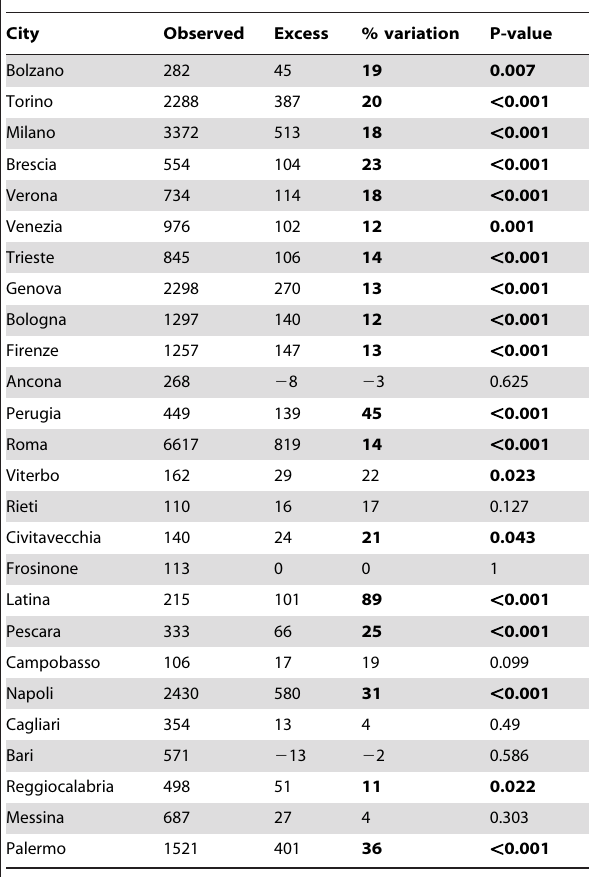
Table 2. Observed, excess and percent variation in mortality among the very old (75 years and over) during the winter season (December 2011–March 2012) in major Italian cities.